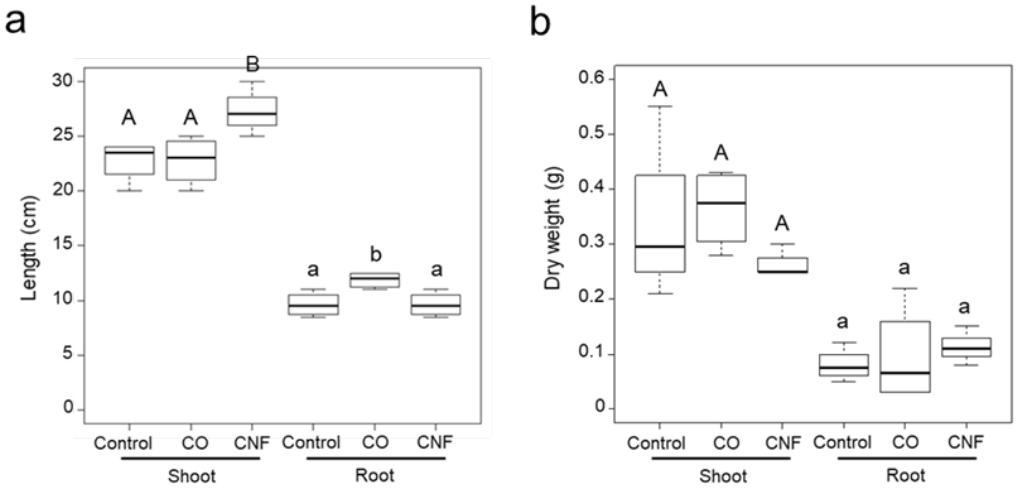
Figure 1. The effects of chitin supplementation to soils on soybean plant growth. The soybean plants were grown on soil mixed with equal volume of 0.01% ( w/v ) chitin oligosaccharide (CO) solution or chitin nanofiber (CNF) dispersion for four weeks and then harvested for measurement of length ( a ) and dry weight ( b ) of shoots and roots. Data are shown as mean and SE ( n = 4). Different letter types (uppercase and lower case) denote significant differences (Tukey’s HSD test, P < 0.05). Data are representative of three independent biological experiments, showing similar results.